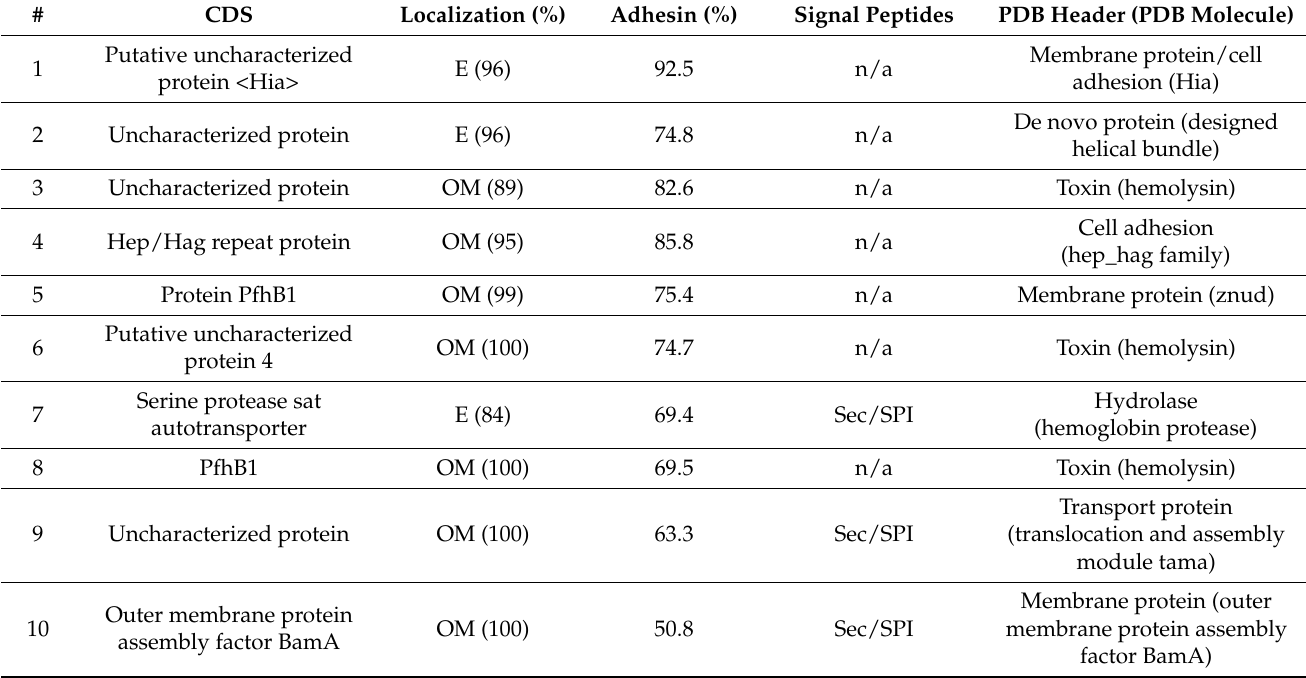
Table 6. Three extracellular and seven outer membrane localized proteins are the most promising candidates for vaccine development against P. atlantica (NVI 9100 and UiBP1-2013). E: extracellular, OM: outer membrane, GI: Genomic island, P: Prophage, and ND: Not